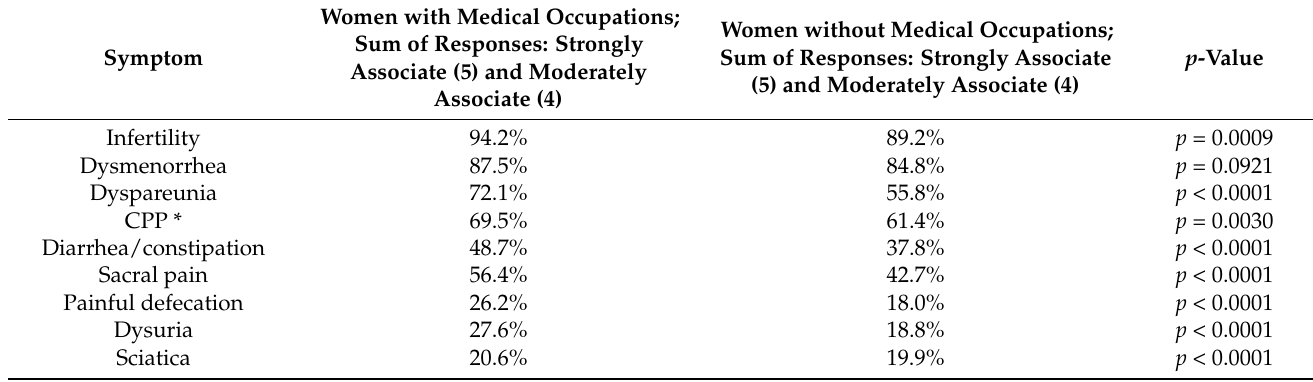
Table 2. Identification of symptoms according to respondents with medical occupations ( n = 548) and without medical occupations ( n =